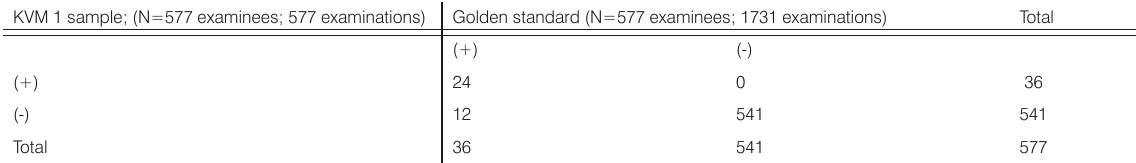
Table 4. Comparison of the results with CM plus CCT (1 sample) and those with "golden